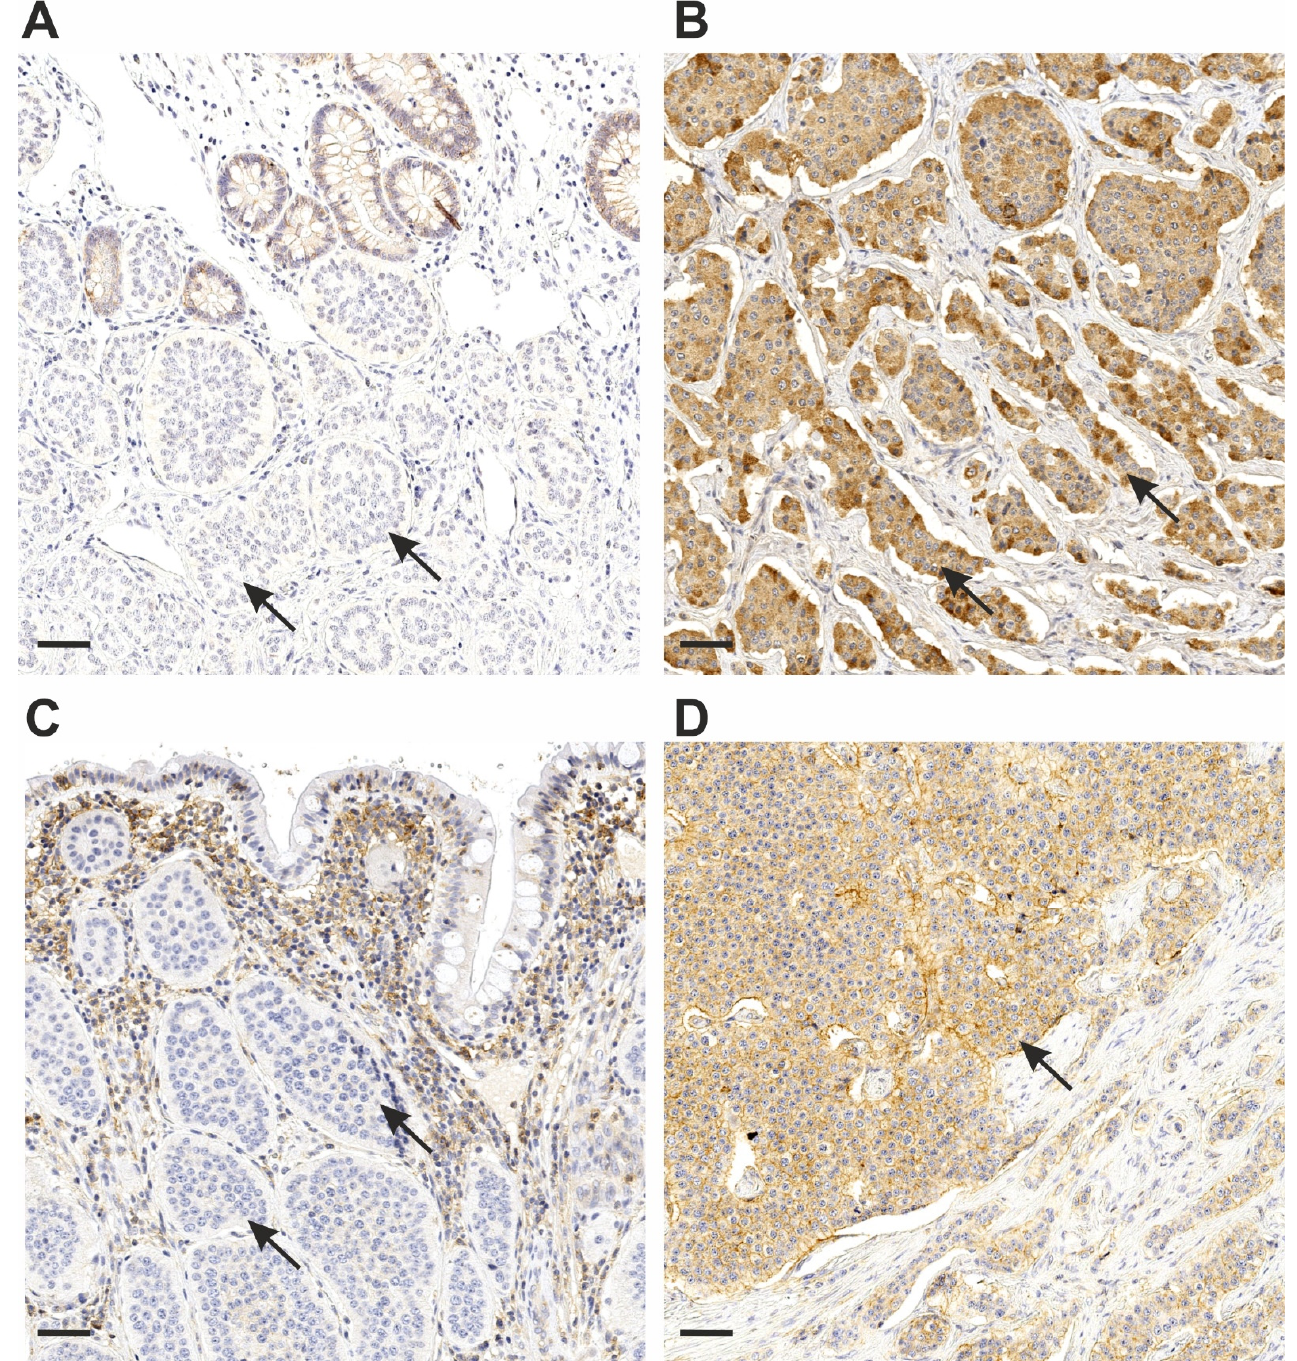
Figure 1. Immunohistochemical staining of MCT1 and MCT4 in representative small bowel neuroendocrine tumor samples showing ( A ) a low MCT1 score, ( B ) a high MCT1 score, ( C ) a low MCT4 score and ( D ) a high MCT4 score expression. The scale bar length is 50 µm (bottom left corner). Arrows indicate MCT-negative ( A , C ) and MCT-positive ( B , D ) tumor cells.